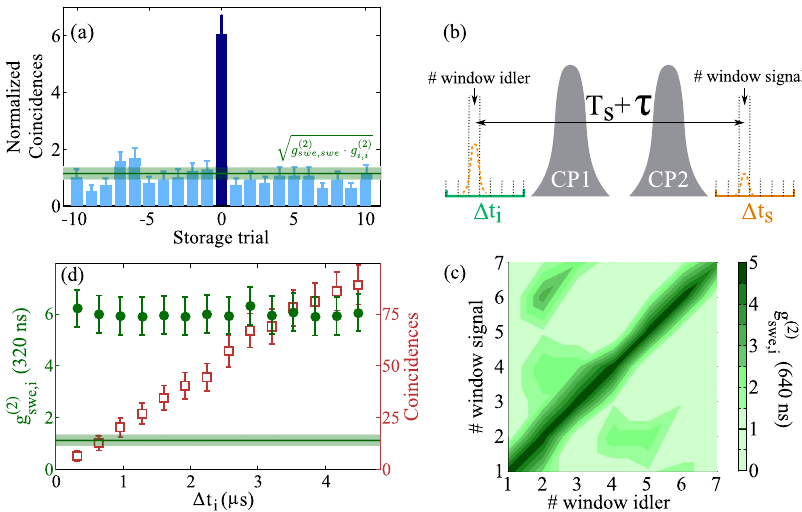
ð 2 Þ ð Δ T ¼ 320 ns Þ value FIG. 3. (a) Unconditional cross-correlation between the idler photons and the retrieved signal photons. The g d swe ;i for this measurement is 6 . 1 (cid:2) 0 . 7 . The classical bound given by the Cauchy-Schwarz inequality is reported as a horizontal line. The error bars are calculated considering Poissonian statistics. (b) Scheme representing the analysis of the cross-correlation measurement to evidence the multimodality. Both idler and retrieved signal integration windows are divided into smaller intervals (640 ns), and the correlation is calculated between intervals separated by different storage time. (c) Cross-correlation value between idler and retrieved signal photons ¼ 640 ns for better statistics. The detected in small temporal modes separated by different storage times. For this analysis, we also set Δ T d ð 2 Þ ð Δ T ¼ 640 ns Þ exceeds the classical threshold for Δ T ¼ 640 ns (reported in the color bar) only for windows separated by the total g d d swe ;i storage time T ¼ 13 . 3 μ s. Violations outside these windows are not statistically significant because of a low number of counts. (d) Cross- correlation value between the idler photons and the retrieved signal photons (full circles) and the coincidence counts in the SWecho (empty squares) as a function of the detection window for the idler photons. Both the signal detection window and the coincidence window remain constant at 4 . 5 μ s and 320 ns, respectively. The classical threshold is also reported as a horizontal line. The integration time for this measurement is 38.5 h. The error bars are calculated considering Poissonian